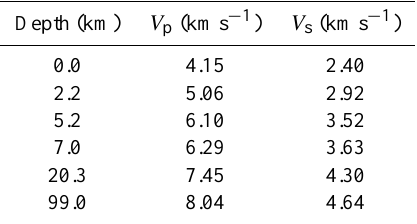
Table 2. Velocity structure used in the location and inversion pro-